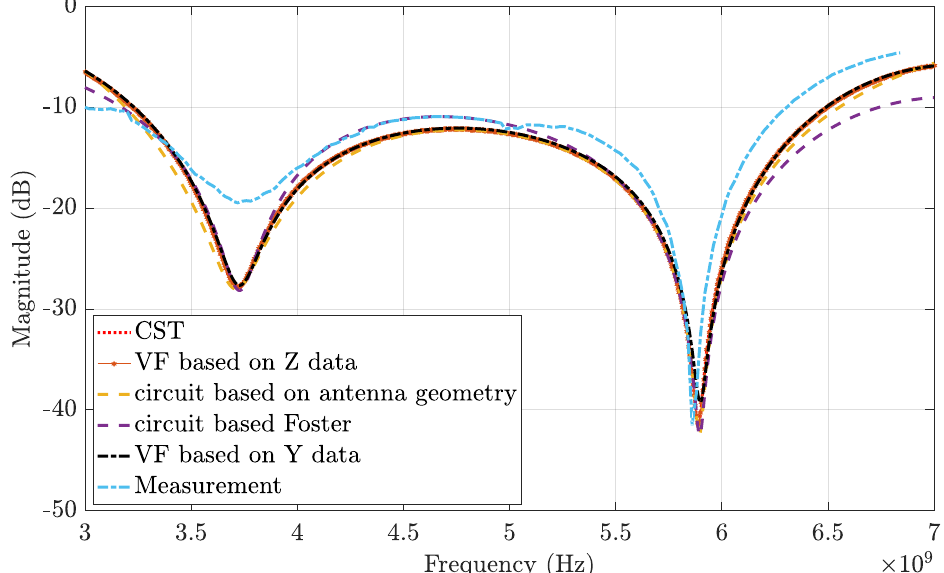
Figure 12. ( a ) Studied antenna prototype; ( b ) the experimental setup.